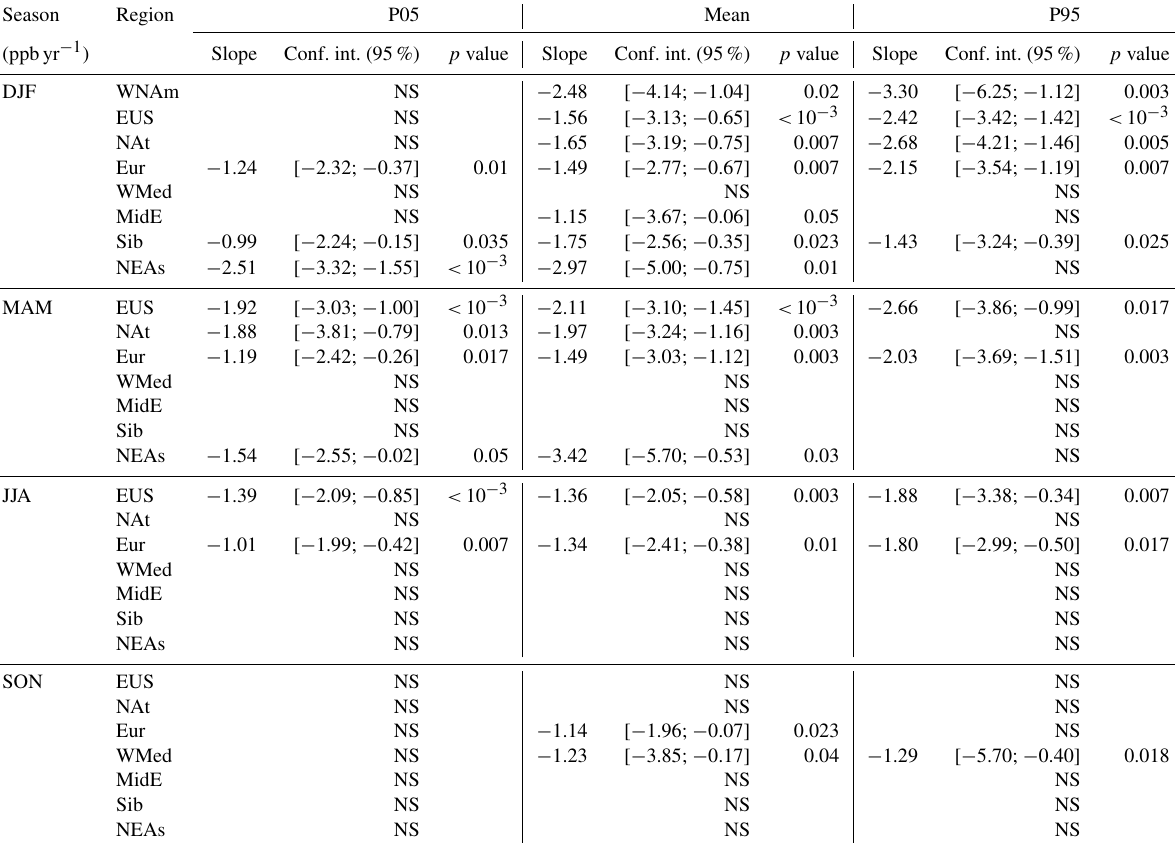
Table D6. CO absolute trends in ppbyr − 1 during each season in the UT. From left to right, the anomalies are taken from deseasonalized P05, monthly means, and P95. The insignificant trends with respect to the 95% confidence level are indicated as NS. Note that the trends in northwest America are available only in